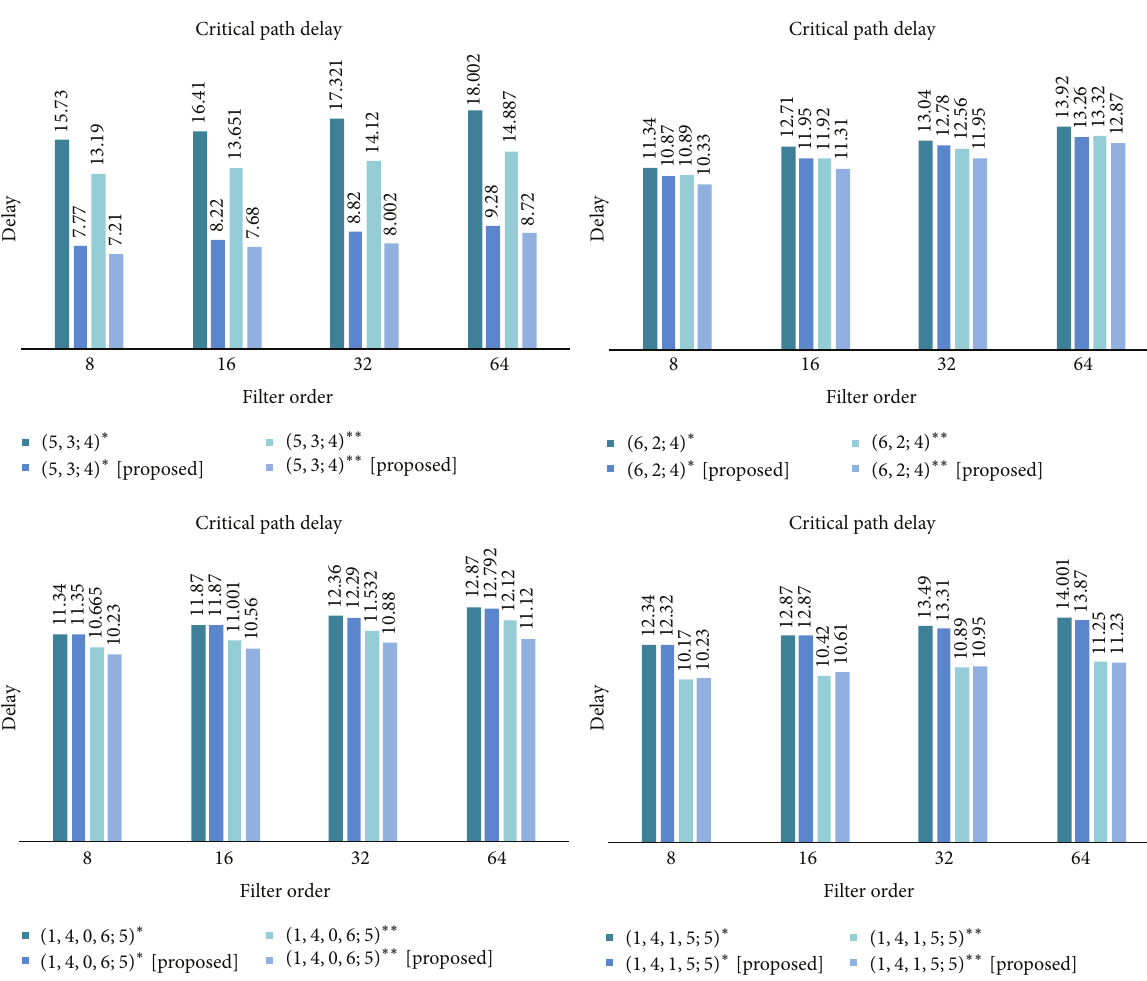
Figure 15: Critical path delay (in nS) for filters based on different GPCs on Kintex-7